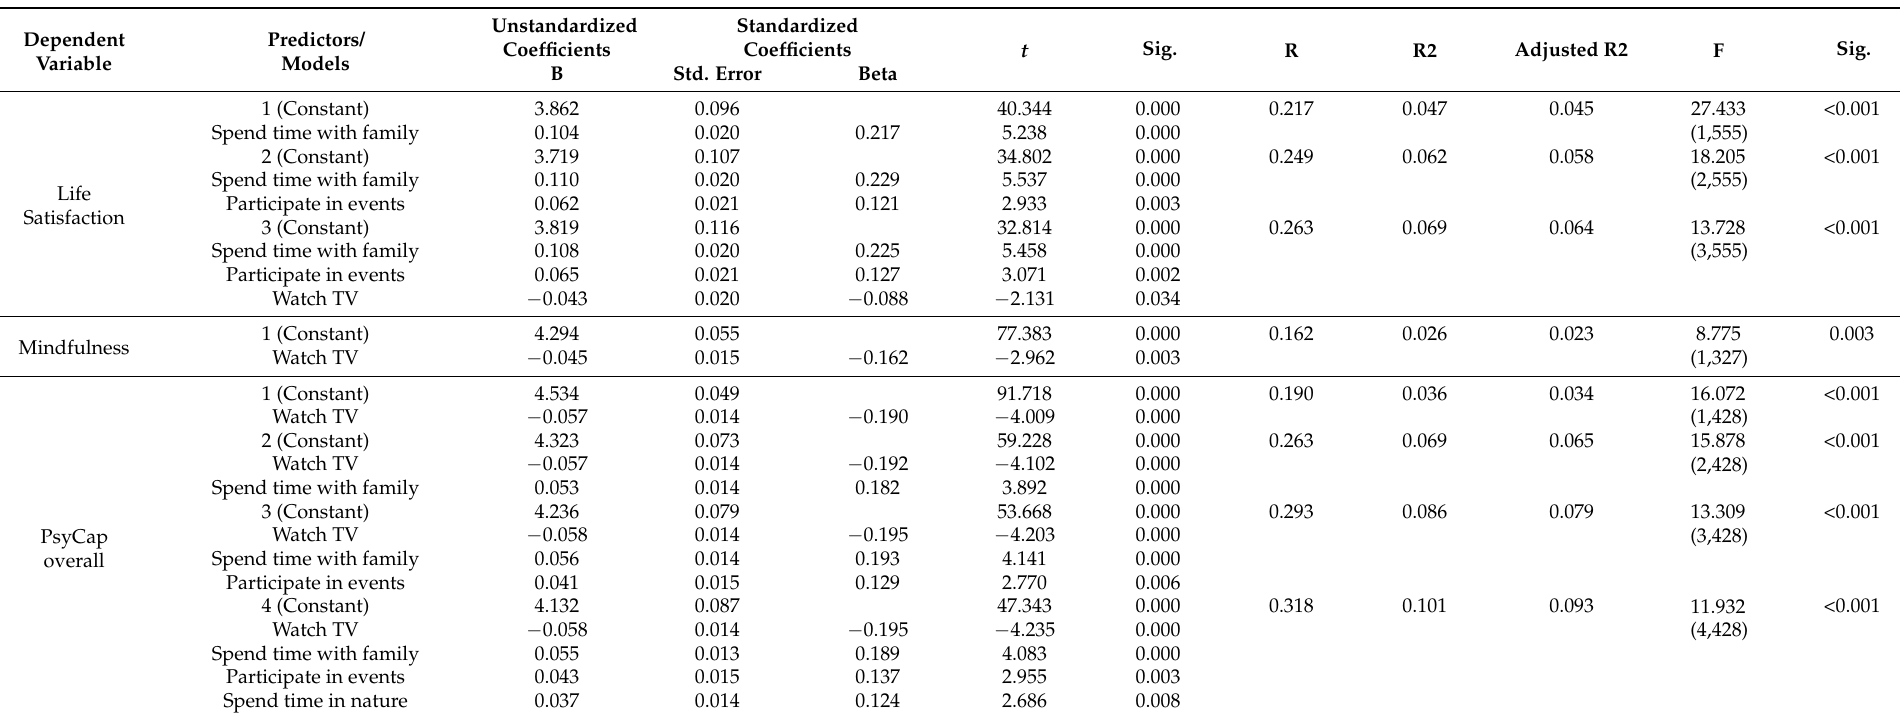
Table 12. Multiple regression model, the dependent variables are life satisfaction, mindfulness, and psychological capital, and the predictors are leisure